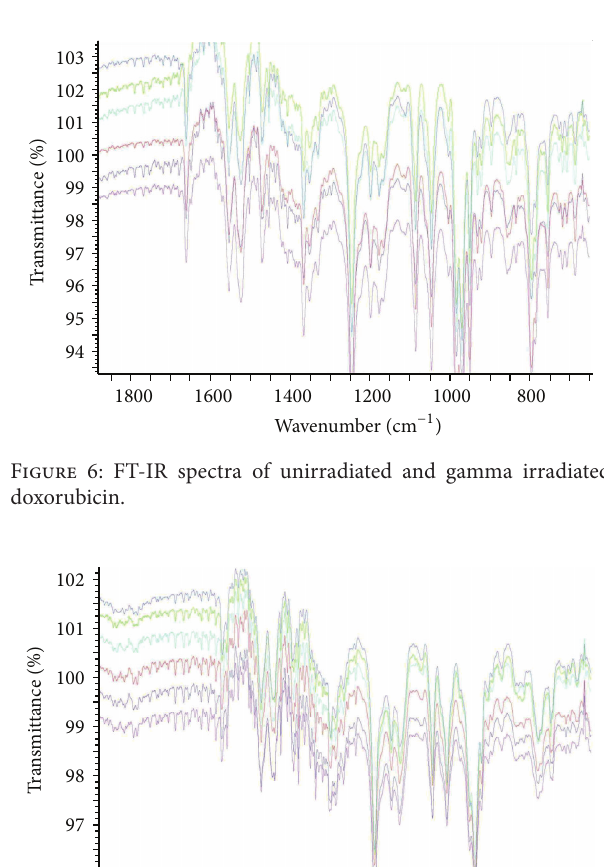
Figure 9: HPLC profile of irradiated daunorubicin (25 kGy).